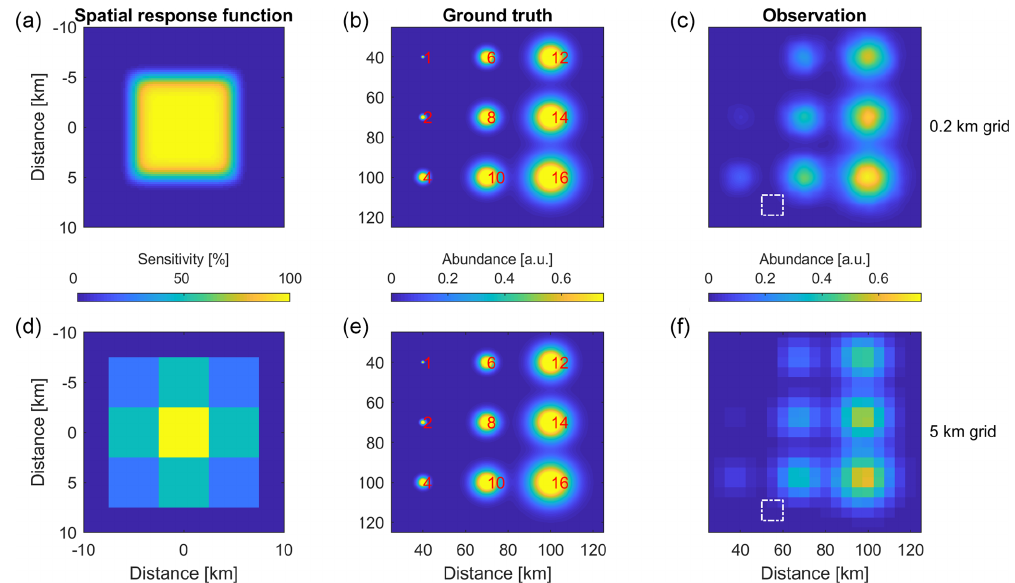
Figure 8. First column: spatial response function of an imaginary sensor discretized at 0.2km (a–c) and 5km (d–f) grids. Second column: ground truth spatial distribution generated as an array of 2-D Gaussian functions of same height (the top and bottom panels are the same). The FWHM of each Gaussian is labeled. Third column: physical oversampling results using 10000 randomly generated observations and discretized at 0.2km (a–c) and 5km (d–f) grids. The pixel size, which determines the spatial resolution, is labeled as the inserted white